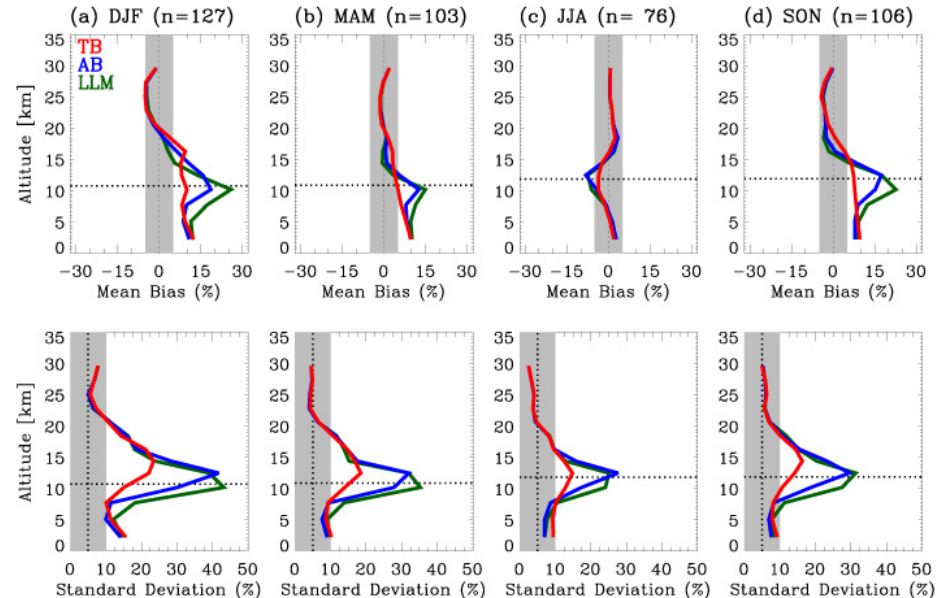
Fig. 9. Mean biases and 1 σ standard deviations between OMI and ozonesonde profiles with convolution using OMI averaging kernels at Hohenpeißenberg during (a) December/January/February (DJF), (b) March/April/May (MAM), (c) June/July/August (JJA), and (d) Septem- ber/October/November (SON) from 2004 to 2008.